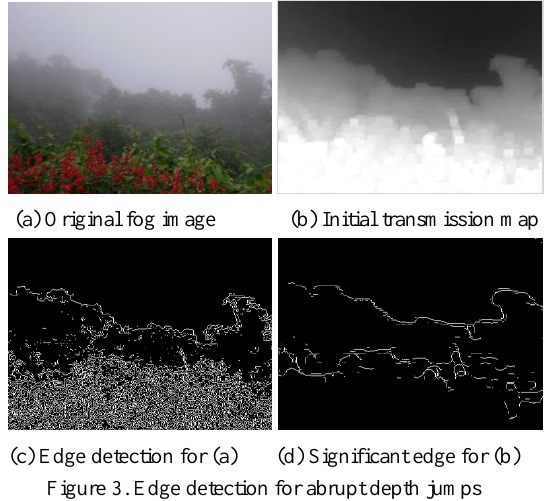
Figure 3. Edge detection for abrupt depth